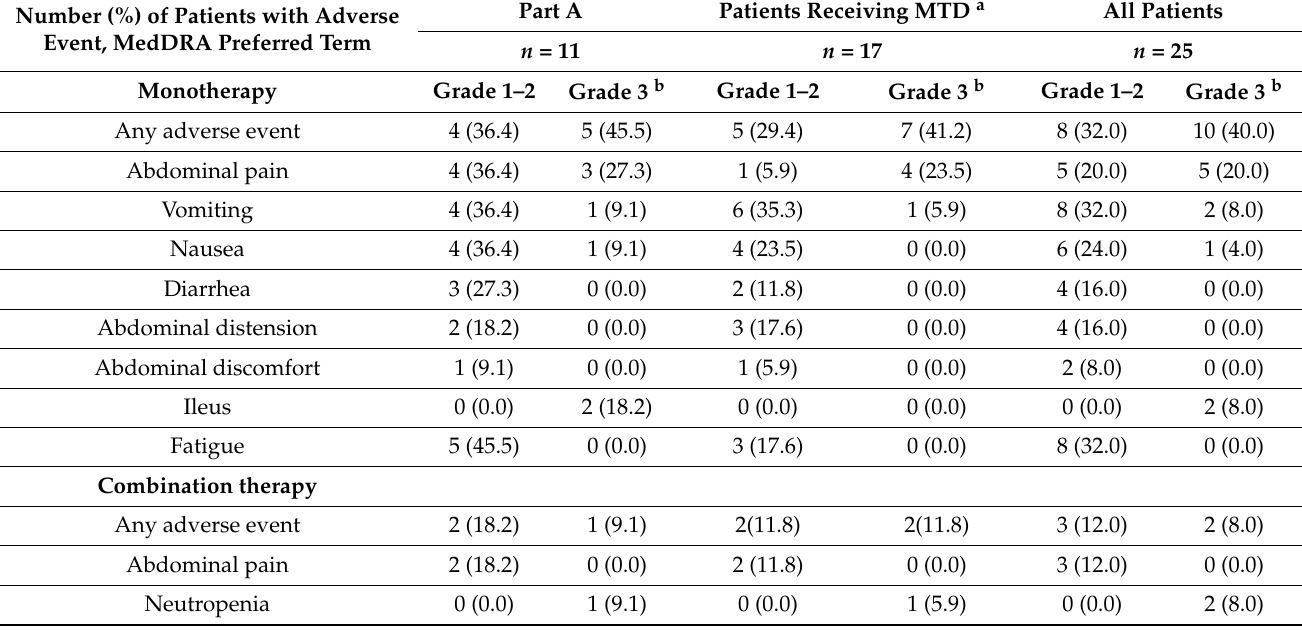
Table 2. Treatment-related adverse events during monotherapy and combination therapy occurring in ≥ 2 patients. Number (%) of Patients with Adverse Event, MedDRA Preferred